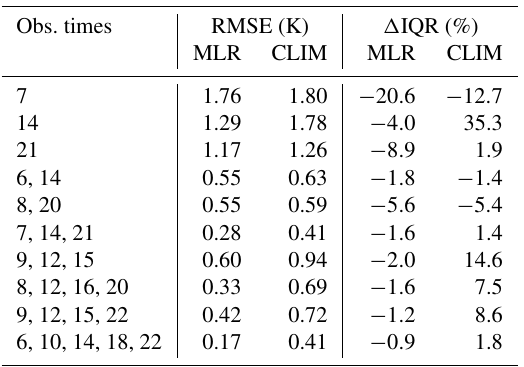
Table 3. Performance of the MLR model compared to a correction based on the climatological diurnal cycle (CLIM) for common com- binations of observation times (expressed in mean solar local time and 24h notation).